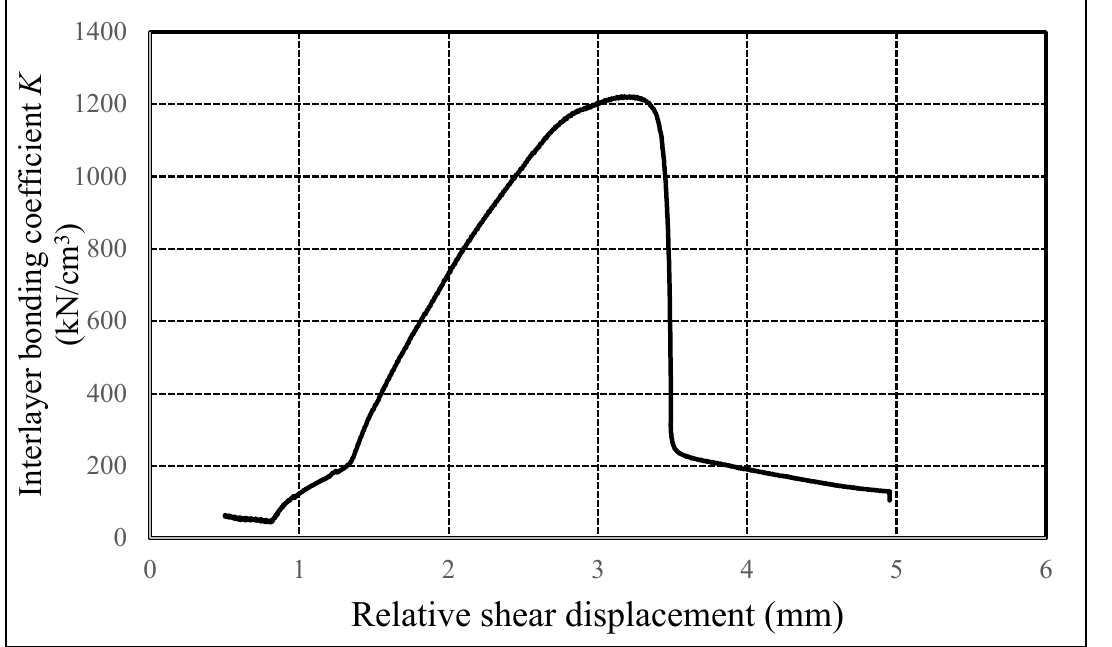
Figure 4. The relationship between interlayer bonding coefficient and relative shear displacement.